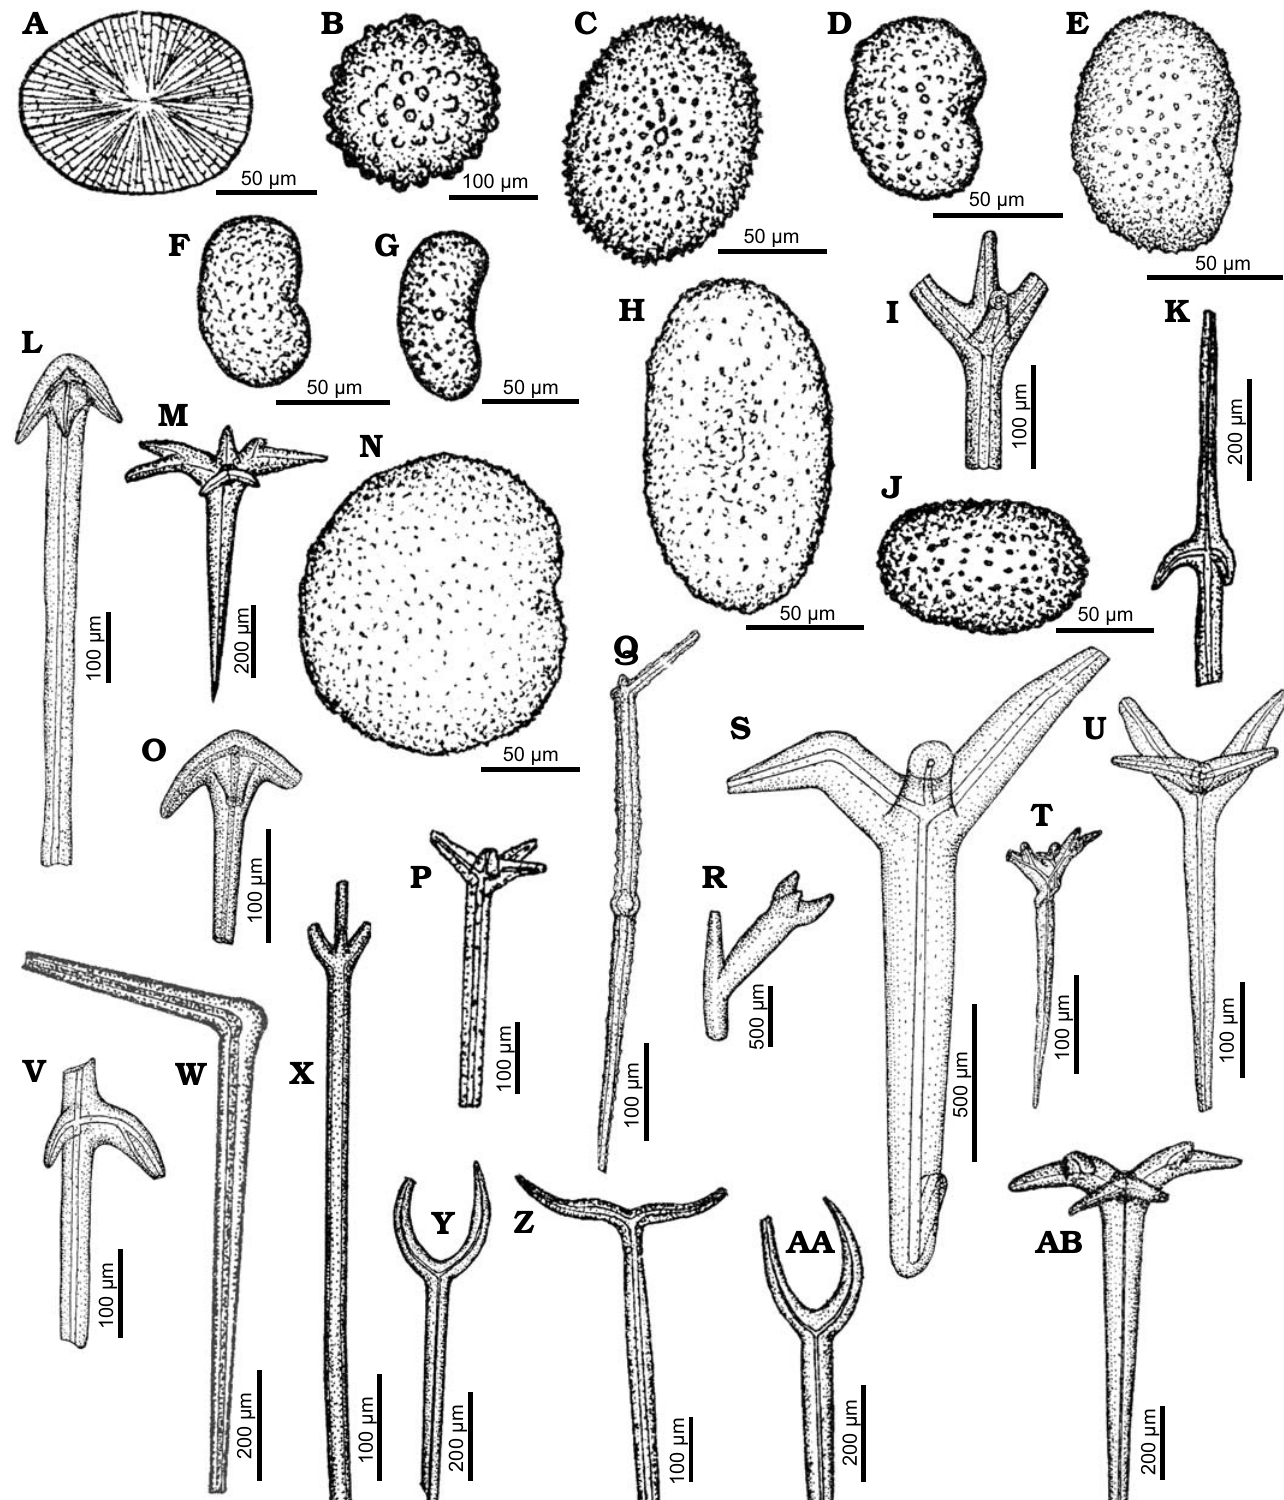
Fig. 1. Spicule morphotypes from south-central Ukraine; Grigorevka borehole, upper Eocene (B), Glâdov Âr, Upper Cretaceous (A, G, J), Pogonovka borehole, upper Eocene (C), Russkie Ti ŝ ki, middle Eocene (D, F, I, O, W, X, Z, AA), Markovka, upper Eocene (E, H, N), Nikol’skoe, upper Eocene (K, L, Q, T, U, V), Pes č anoe, upper Eocene (M, AB), Kantemirovka, upper Eocene (P), Harkov region, middle Eocene (S), Verhnee, lower Eocene (R), and Staroverovka, middle Eocene (Y). A , G , H . Aspidasters. B . Spheraster. C , E , J , N . Sterrasters. D , F. Selenasters. I . Triaene. K , X . Mesotriaene. L , O . Anatriaenes. M , AB . Dichotriaenes. Q . Centrotylote ?oxea. R . ?Triaene. S . Plagiotriaene. P , T , U . Triaenes. V . Irregular triaene. W . Style. Y – AA . Diaenes. After Ivanik (2003);